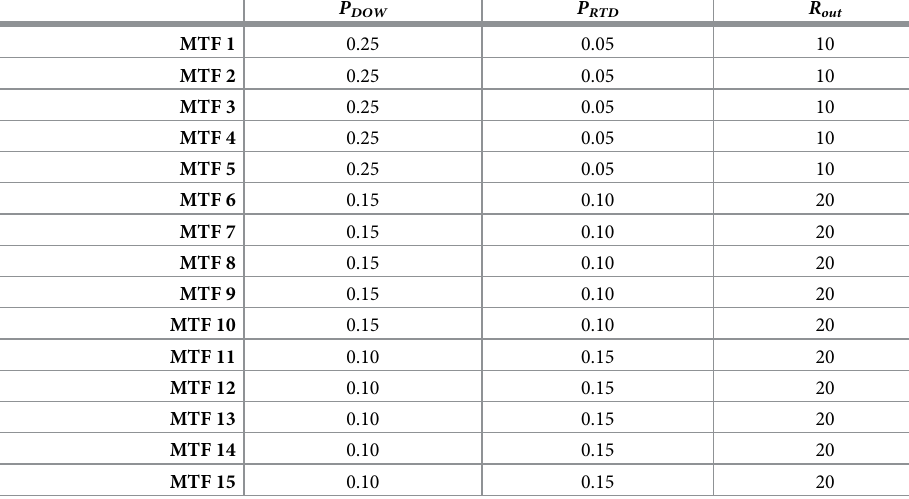
Table 3. Characteristic parameters of each MTF. P DOW is the probability that a given casualty in the MTF will die of wounds in a given time step, P RTD is the probability that a given casualty in the MTF will return to duty in the given time step, and the R rate is the number of casualties (up to the total number of casualties present in the MTF) sent out from the MTF to a hospital. P